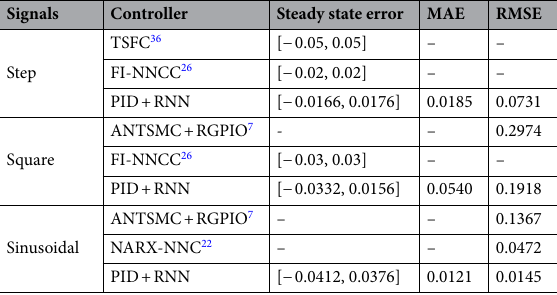
Table 8. Experiment comparisons of tracking signals under the different